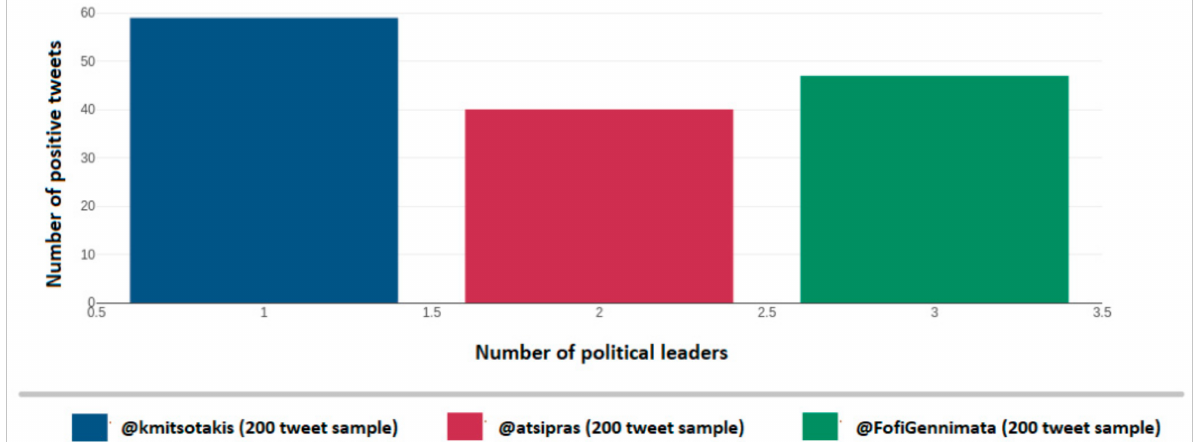
Figure 27. Positive identified tweets for the top three Greek pollical leaders (600 tweet sample). Figure 28 depicts the identified tweets that indicate neutral mood per political account on Twitter namely for Kyriakos Mitsotakis (@kmitsotakis), Alexis Tsipras (@atsipras), and Fofi Gennimata (@FofiGennimata). Axis y depicts the number of identified neutral mood tweets over the 200-tweet sample, while the x axis depicts the number of political leaders.